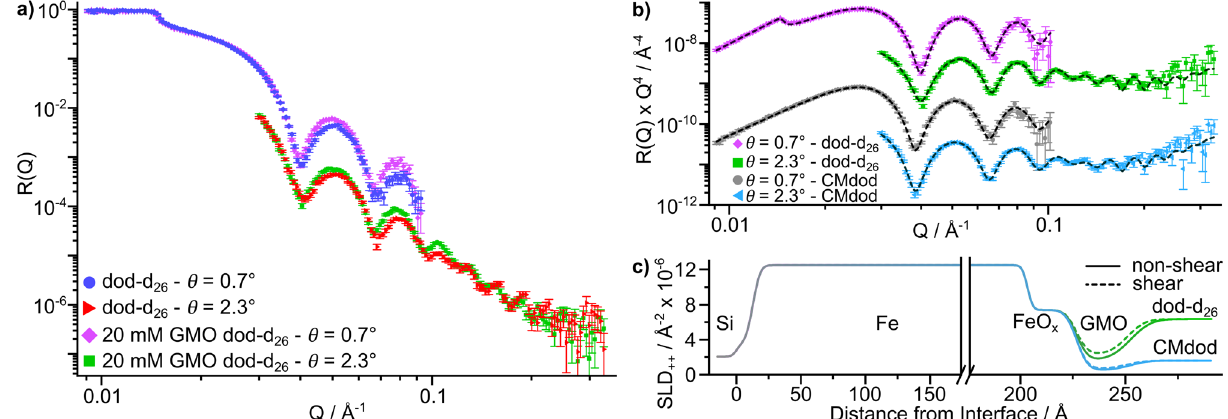
Figure 6. NR data, fits and SLD profiles for the GMO-dodecane systems. ( a ) Comparison of NR data for dodecane- d 26 with and without GMO entrained against iron-coated silicon substrates at 7.0 × 10 2 s − 1 . Data collected at θ = 2.3 ◦ are offset by 10 − 1 in the vertical axis. ( b ) NR data for 20 mM GMO in dodecane- d 26 and CMdod entrained against an iron-coated silicon substrate at 7.0 × 10 2 s − 1 . Best fits shown by dashed lines. The reflectivity has been modified by a Q 4 factor to aid comparison. Data are offset in the vertical axis for clarity. ( c ) Spin-up scattering length density, SLD ++ , profile from the median values of the GMO-dodecane system. A small SiO 2 layer was modelled between the Si and Fe layer but is not labelled for clarity. Here, SLD ++ = SLD n + SLD m